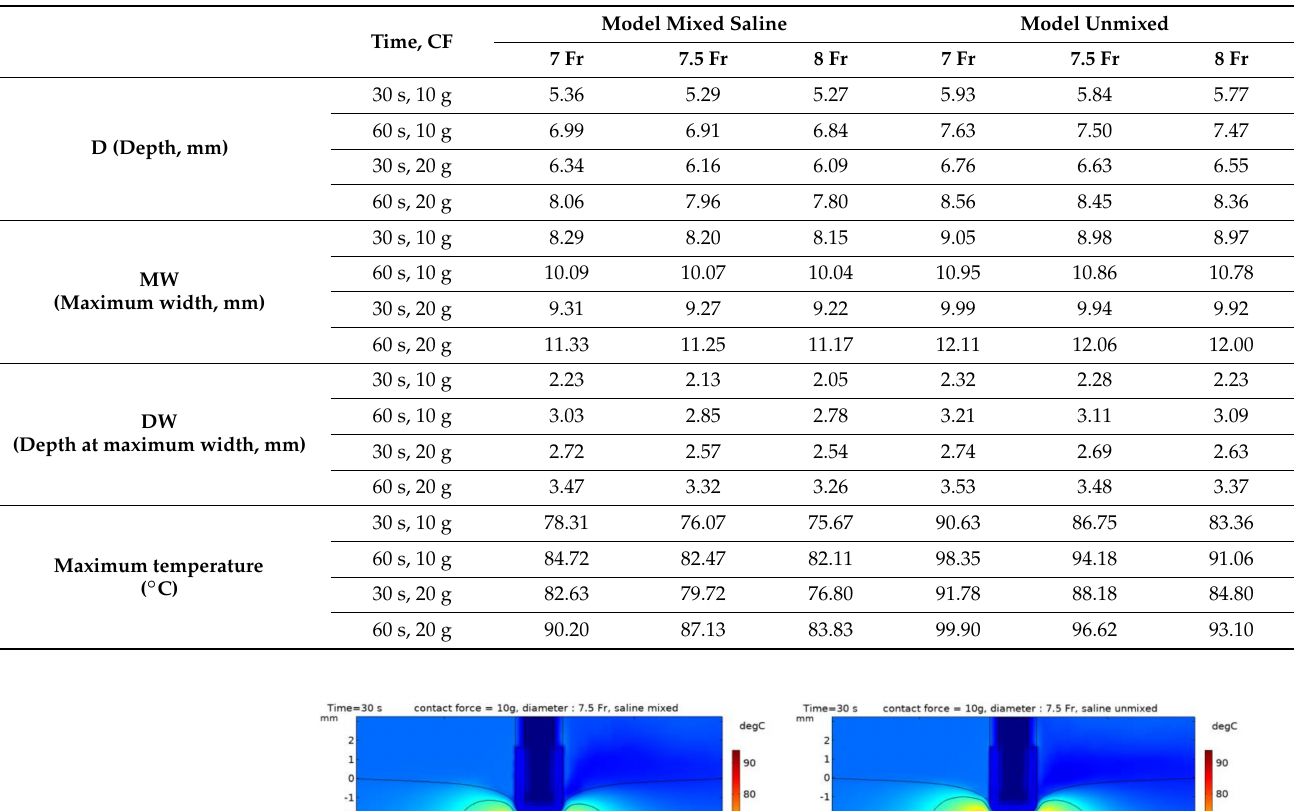
Table 3. Thermal lesions and the maximum temperature of heat tissue based on the catheter diameter, contact force, time, and status of mixing between saline and blood.